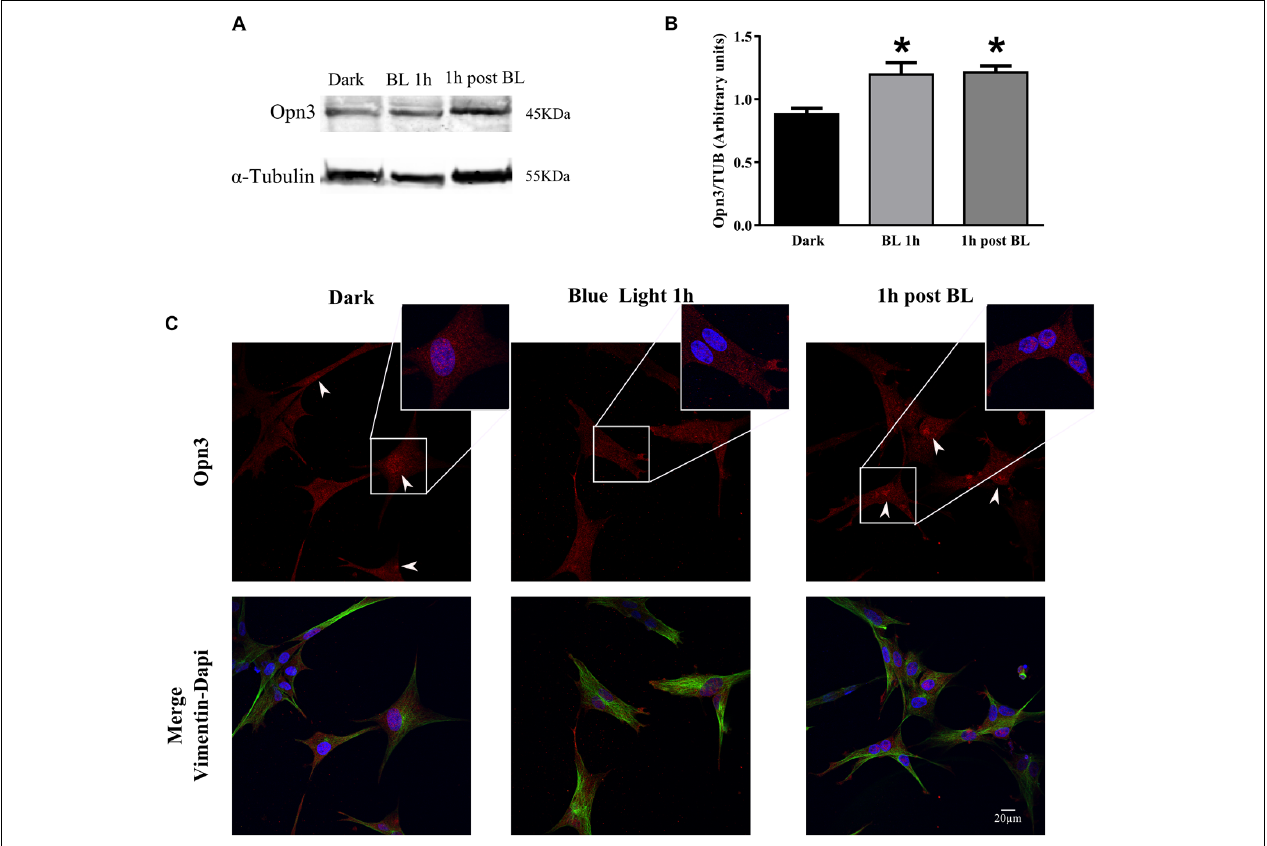
FIGURE 4 | Effect of blue light on Opn3 protein in primary cultures of Müller glial cells. (A) Analysis of Opn3 protein in Müller cells at different light conditions by WB. Immunoblots show two bands of ∼ 43–45 kDa for Opn3 protein in the three experimental conditions: dark, blue light for 1 h (BL 1 h), and 1 h post-BL. (B) The histograms show the media ± SEM of Opn3 levels in the three illumination conditions. Increased Opn3 protein levels in Müller glial cells cultures were observed for 1 h of BL stimulation and 1 h after BL exposure over the dark control [ ∗ p < 0.01 by one-way ANOVA F ( 2 , 9 ) = 8.48, n = 3–5/group]. (C) Localization of Opn3 immunoreactivity in Müller cell cultures by ICC for Opn3 (red), the intermedium filament marker Vimentin (green), and DAPI (blue), further magnified in the insets. Opn3-like protein was localized in inner cellular membranes with a strong labeling surrounding the nucleus in darkness and 1 h post-BL conditions, where nuclear accumulations were detected (see insets for higher magnification). By contrast, cell cultures exposed to BL for 1 h did not show substantial nuclear-like accumulation of Opn3 immunofluorescence. Scale bar = 20 µ